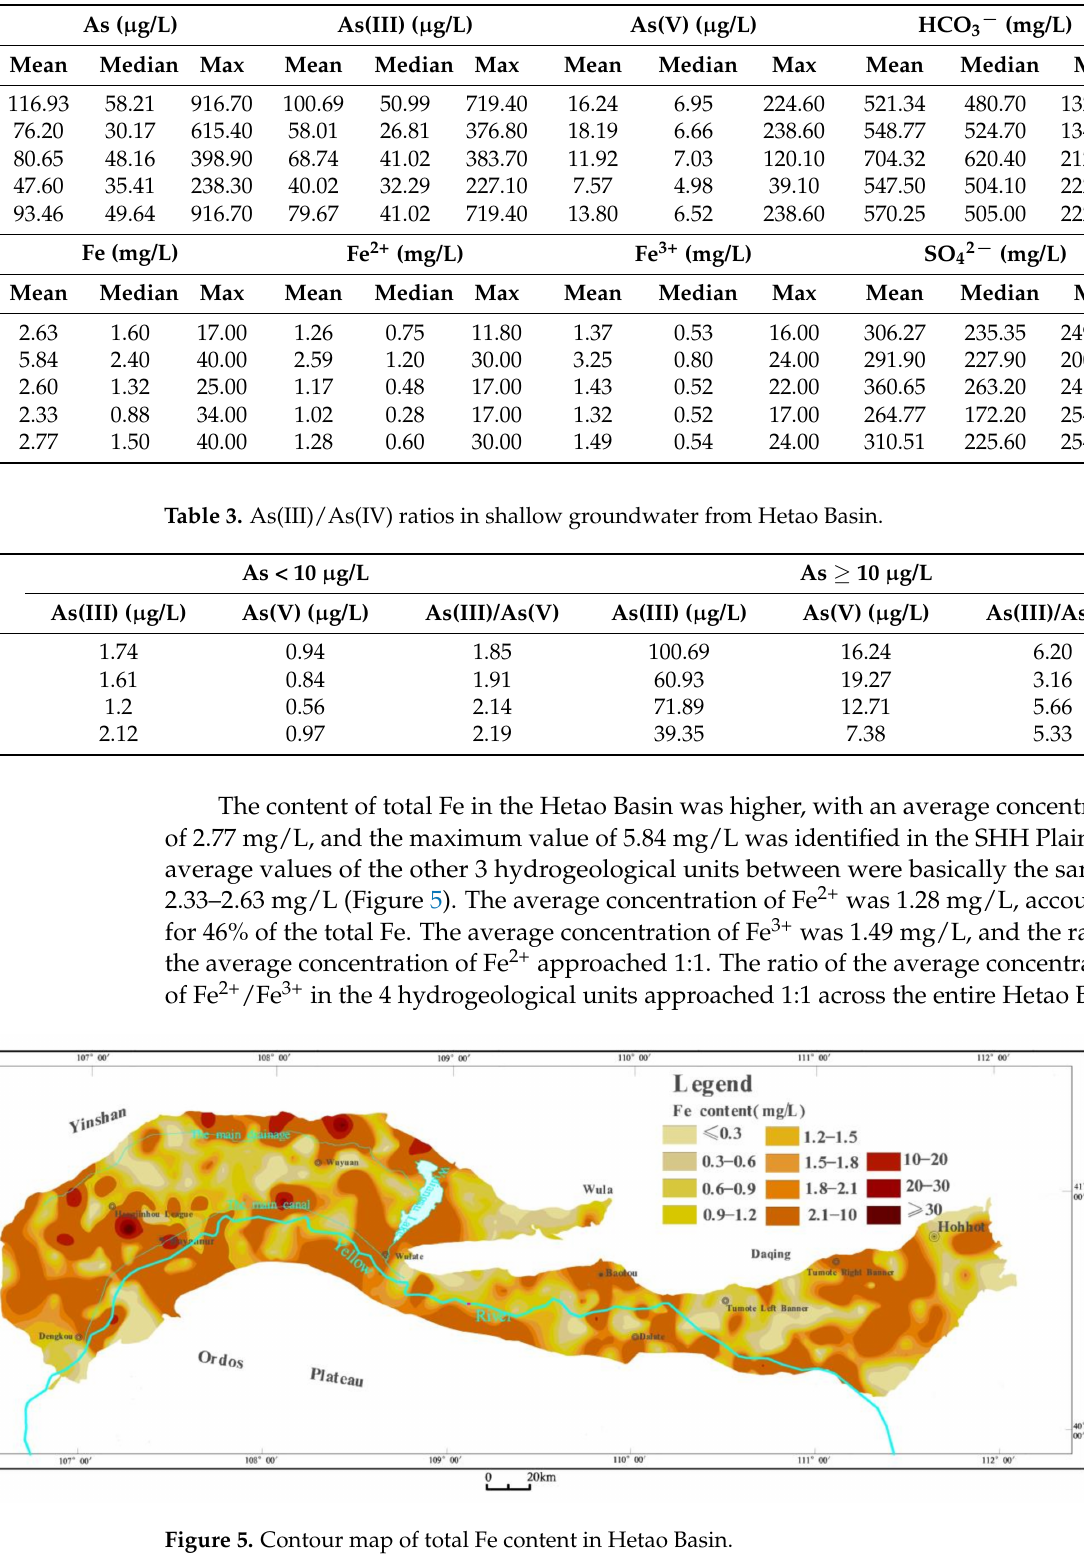
Table 2. Statistical table of characteristic values of the main ions in high-As shallow groundwater in the Hetao Basin.